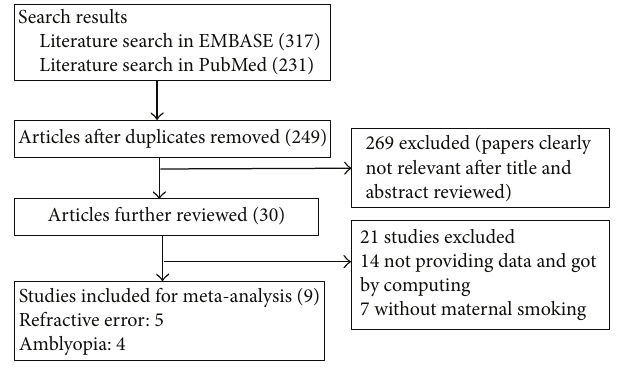
Figure 1: Flowchart of studies search and